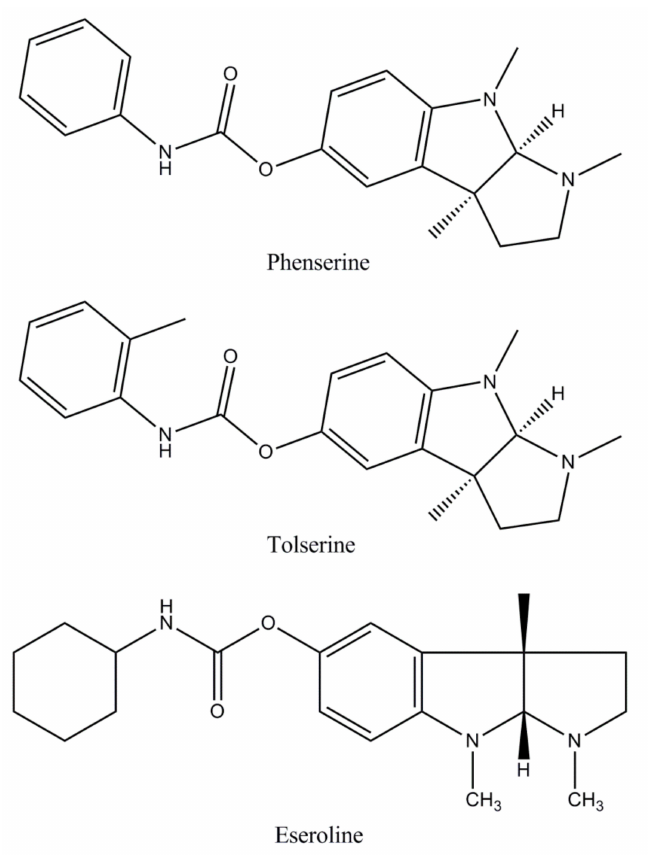
Figure 4. The structures of ChEIs in development: Phenserine, Tolserine, and Eseroline.